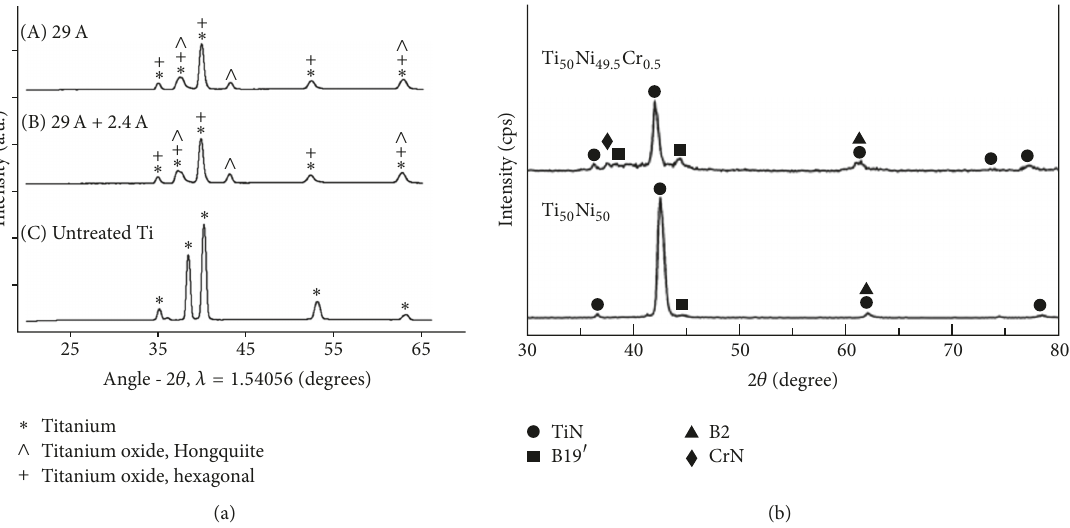
Figure 22: It depicts XRD patterns showing titanium oxide and nitride layers deposition after electrodischarge coating. Copyright @Elsevier, reproduced with permission from Elsevier [87,